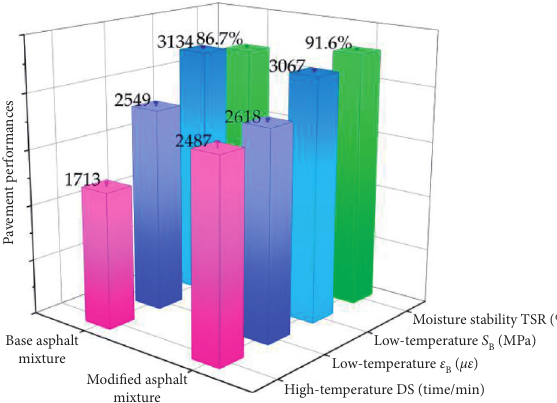
Figure 9: Pavement performances’ comparison results.